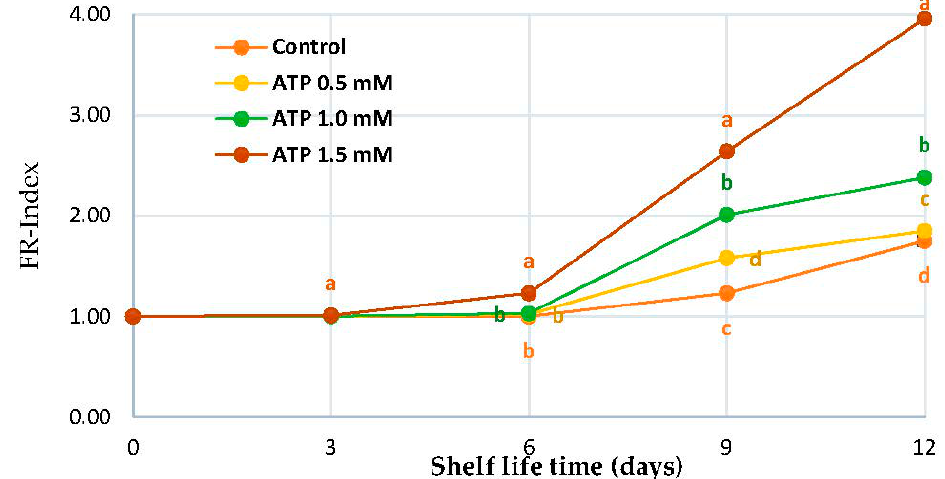
Figure 1. FR-index of ‘Zaghloul’ date fruit treated with ATP at different concentrations (0, 0.5, 1.0, and 1.5 mmol L − 1 ) during storage at 27 ± 1 °C, 67 ± 3% R, for 12 d. Each value represents mean ± SE ( n = 3). The letters differ ( p < 0.05) and represent the significance between treatments using the Tukey–Kramer HSD test to compare the different